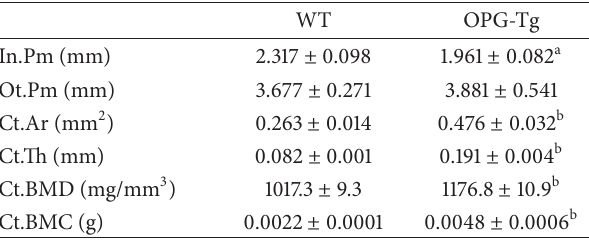
Table 3: Comparison of cortical bone structural